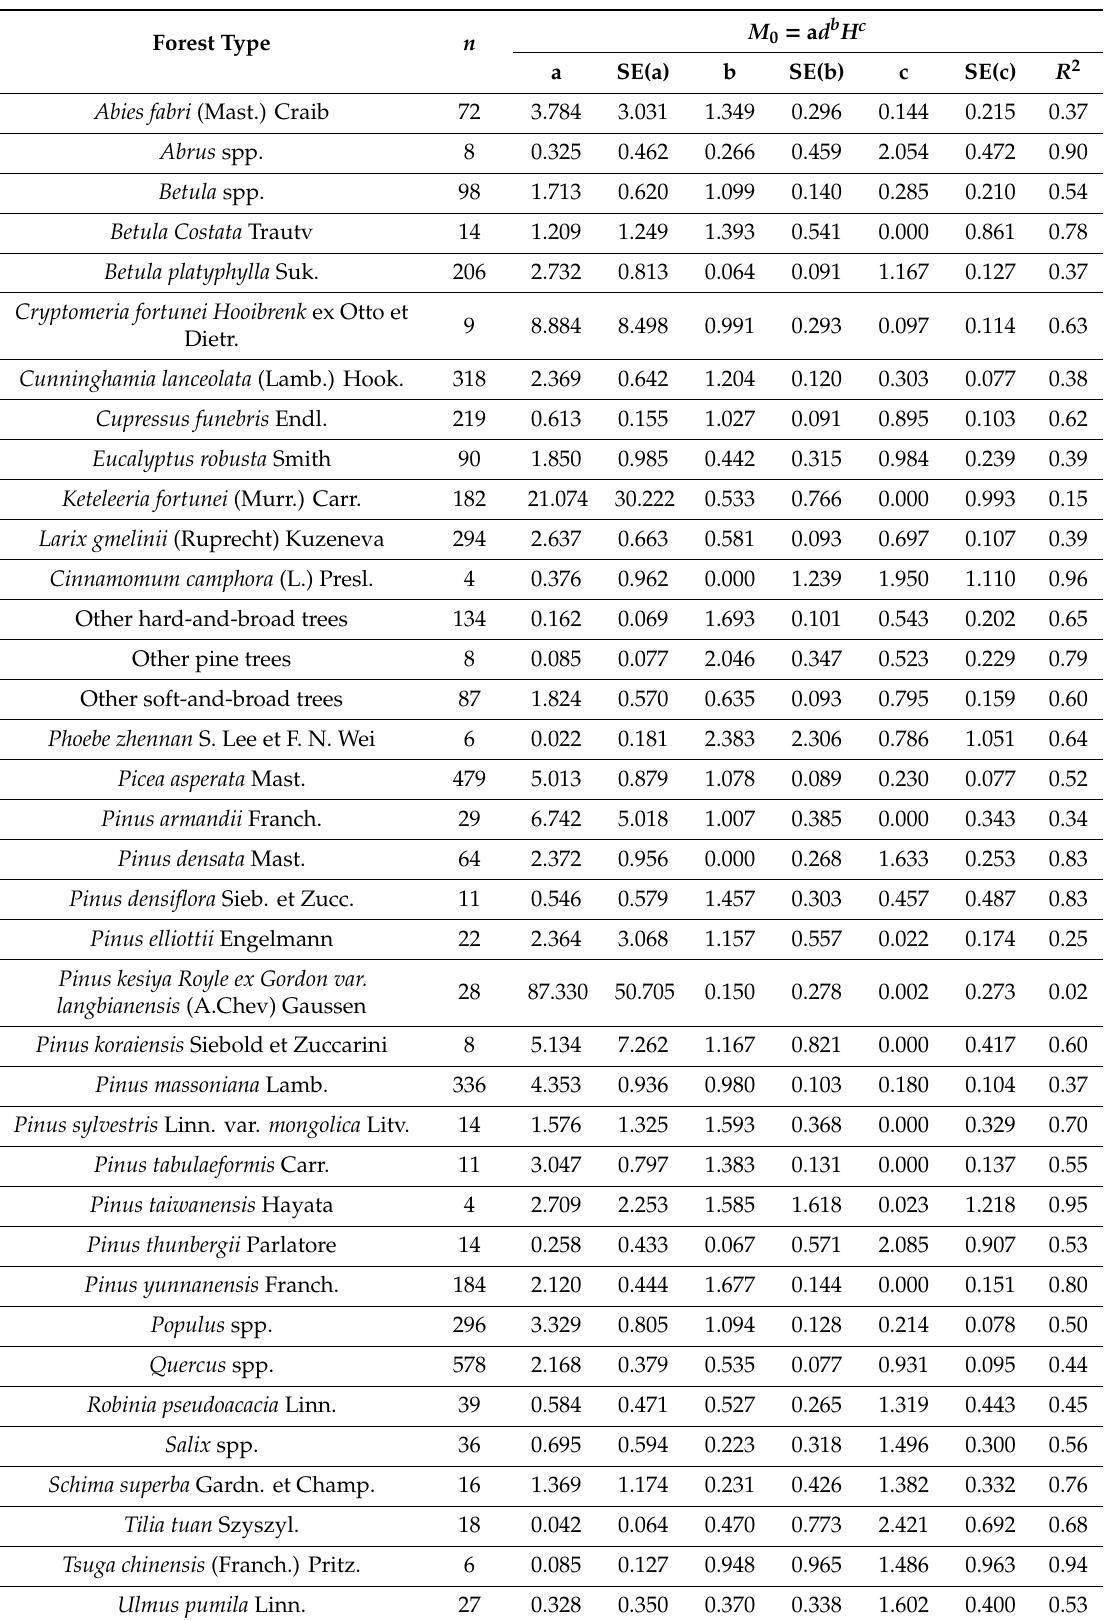
Table A3. Fitting results for binary volume